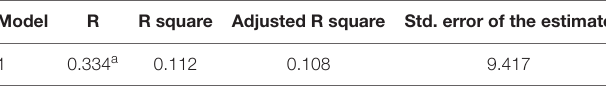
TABLE 4 | Regression model